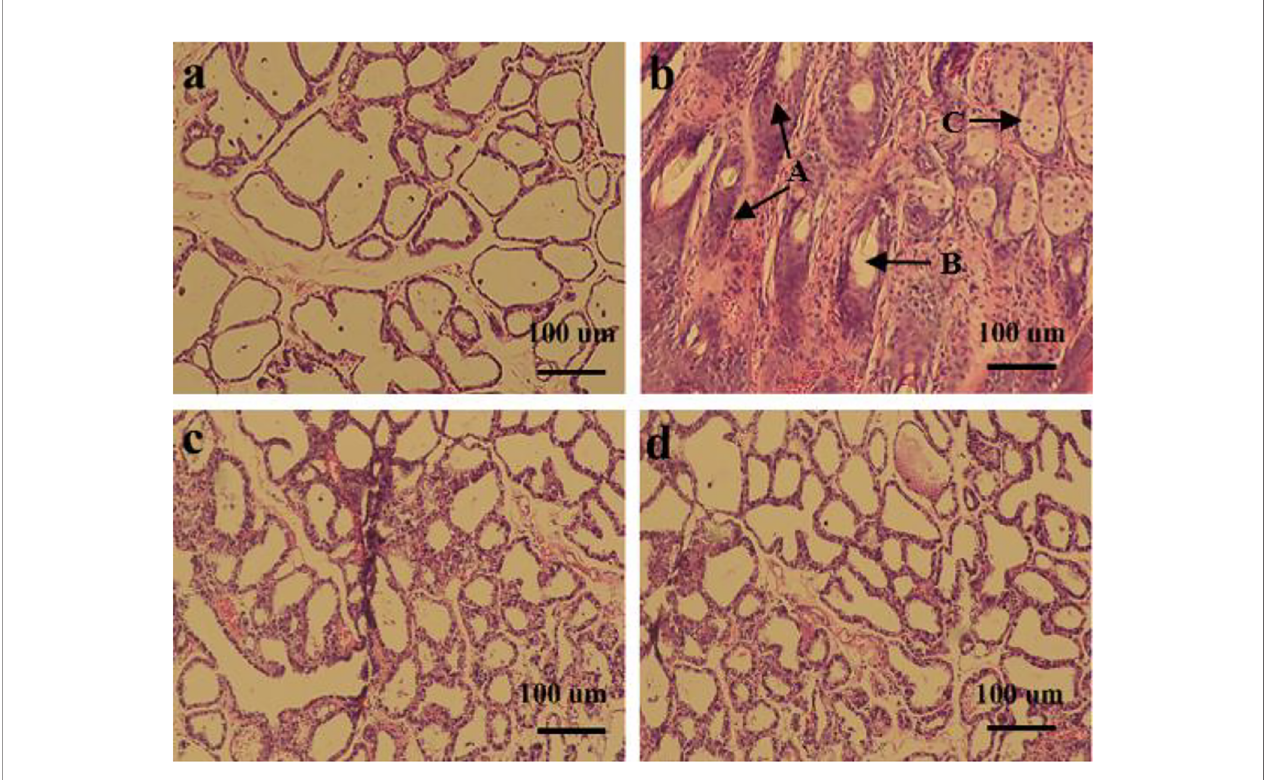
FIGURE 3 | Histopathological changes of mouse mammary glands (A) control group; (B) LPS group; (C) Lactobacillus plantarum pretreatment group; (D) dexamethasone group. The picture indicates A = Tissues necrosis (degeneration), B = Polymorphonuclear neutrophil (PMN) and lymphocytes, C = macrophages.